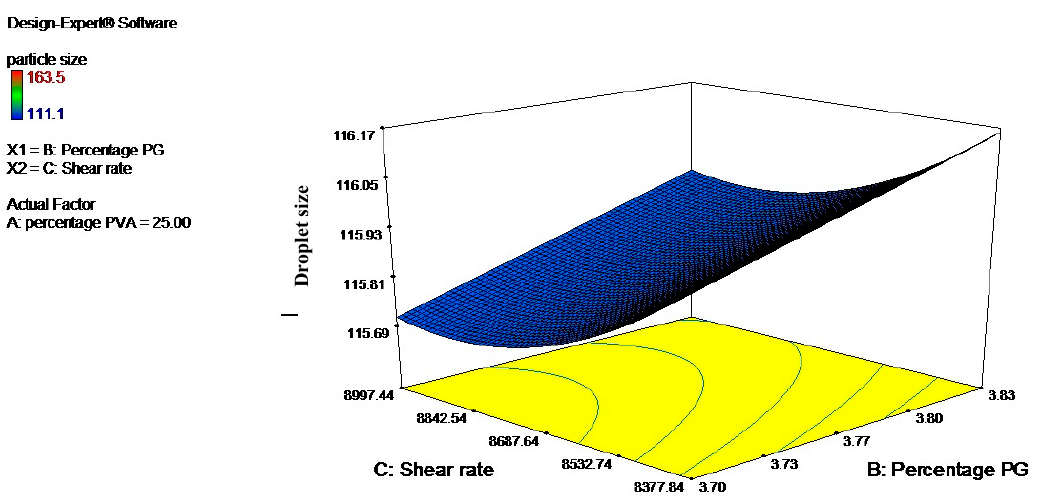
Figure 3. Three-dimensional surface graphs showing the e ff ect of percentage PG and shear rate on droplet size; percentage PVA was kept